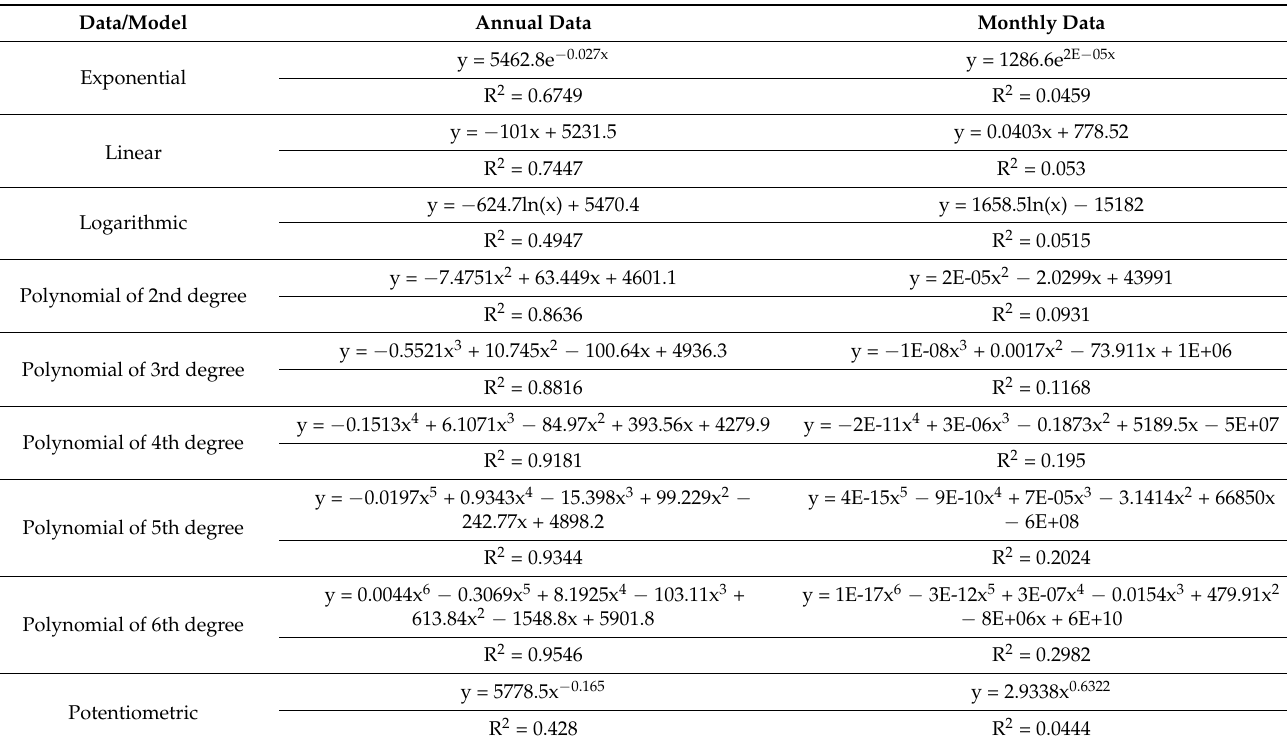
Table A5. Trend models for Ł ó d´z